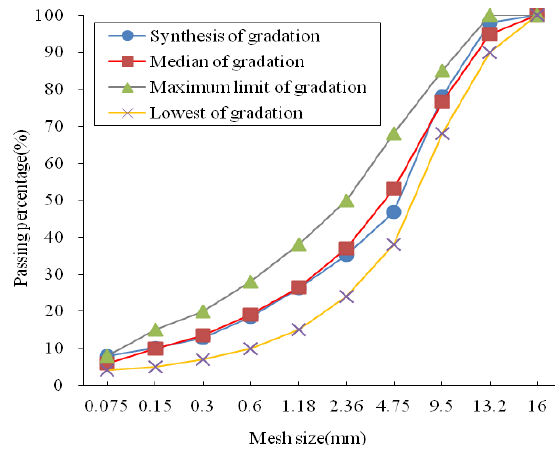
Figure 1. Gradation curve of AC13 asphalt mixture.